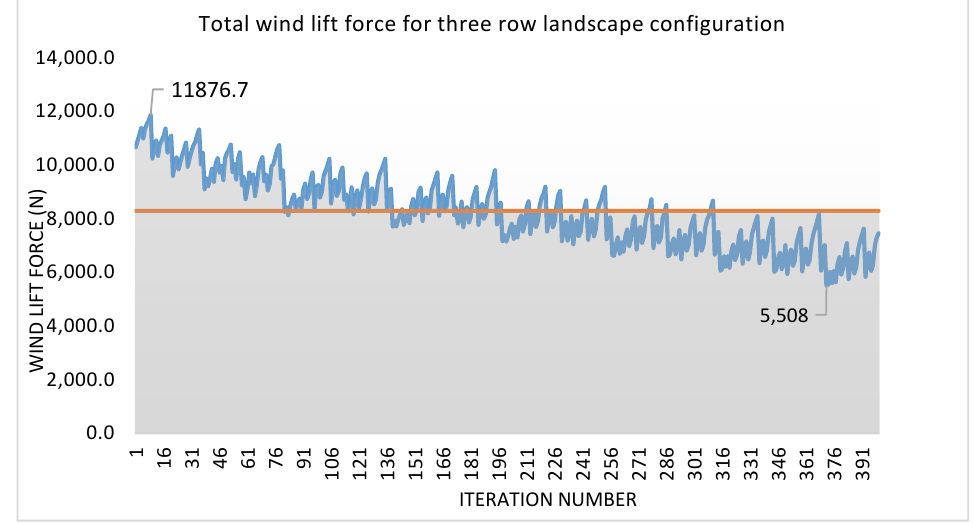
Figure 11. Convergence of lift force values (Objective Function) for case III.